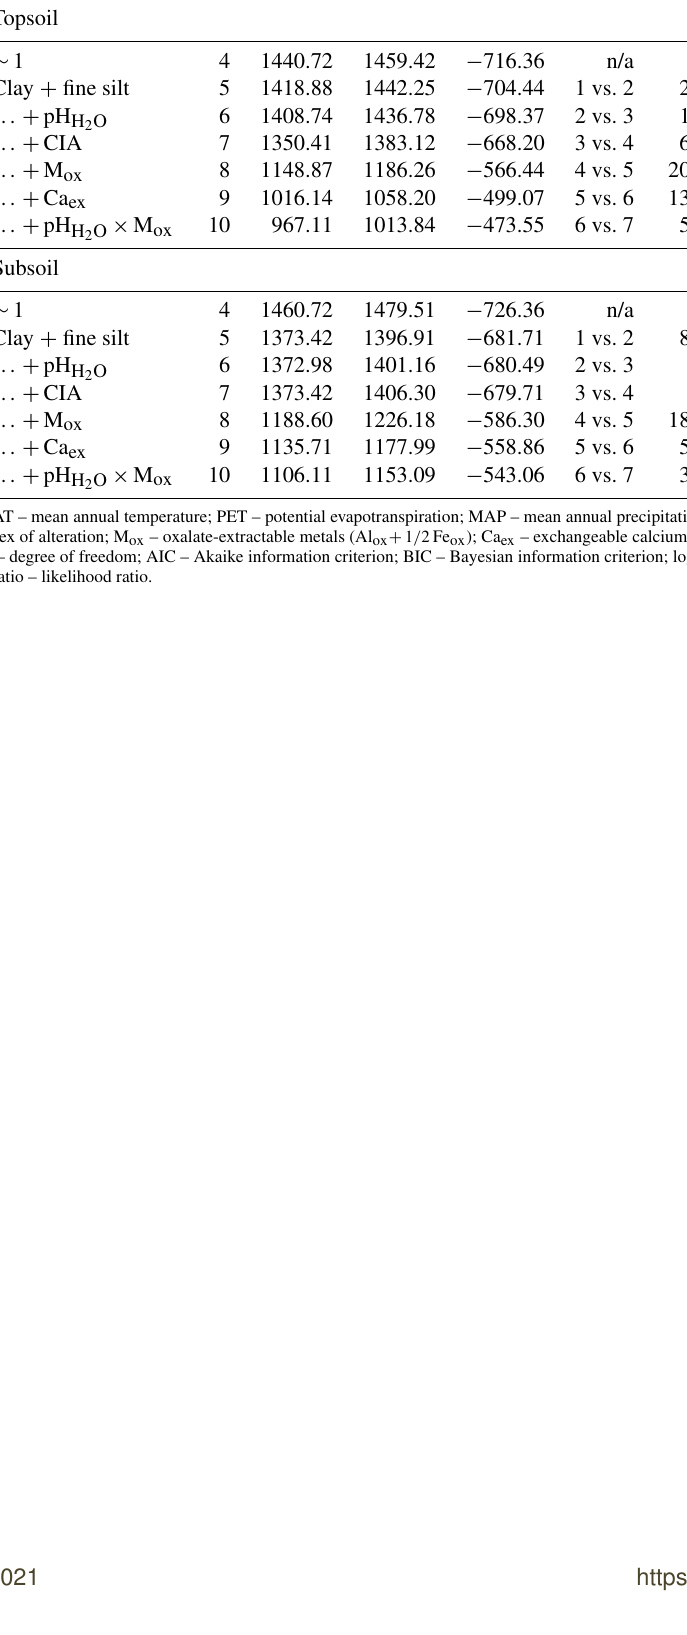
Table B5. ANOVA summary for linear mixed-effects grouped by depth ( n Topsoil = 791; n Subsoil = 810). Fixed effects were added using a step-wise method. The first entry ( ∼ 1) refers to the constant null model, respectively. d